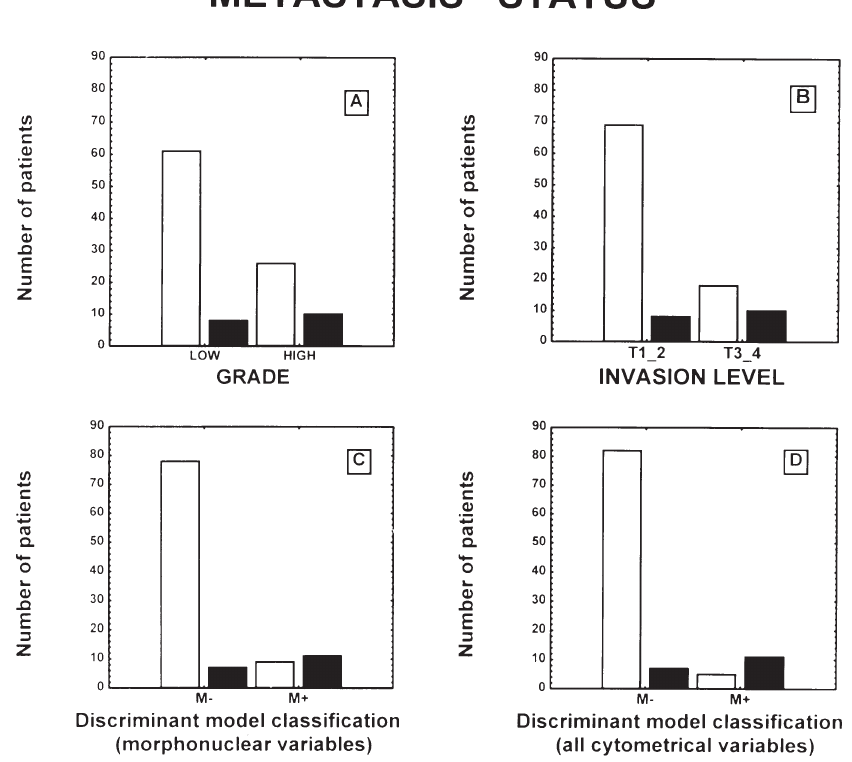
Fig. 1. This figure shows the breakdown of patients who did (M + group, black column) or did not (M − group, white column) show metastases (by the time of their nephrectomy) in function of tumour grade (A) and invasion level (B). Figures (C) and (D) show the classifications results obtained by means of discriminant analysis performed on morphonuclear variables only (C) and on both DNA ploidy-related and morphonuclear variables